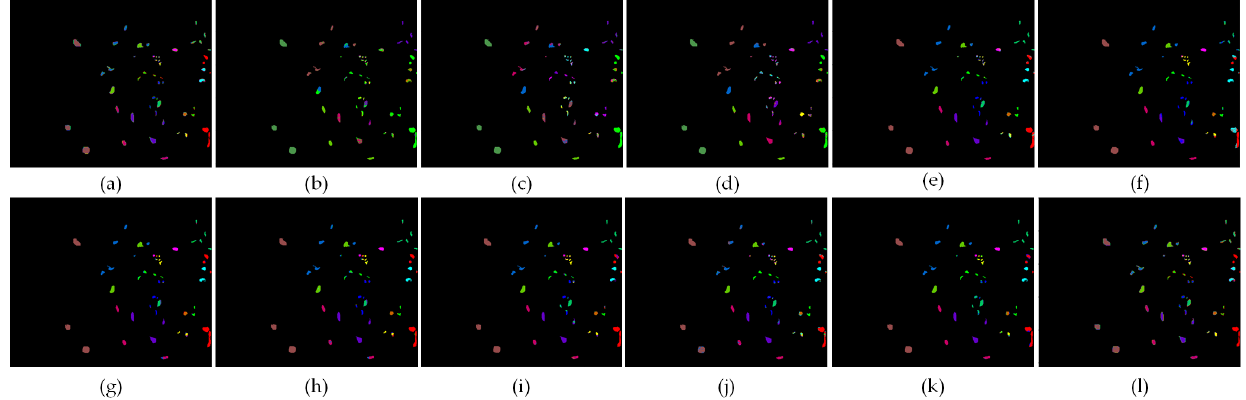
Table 7. Classification results of different methods for the KSC dataset.